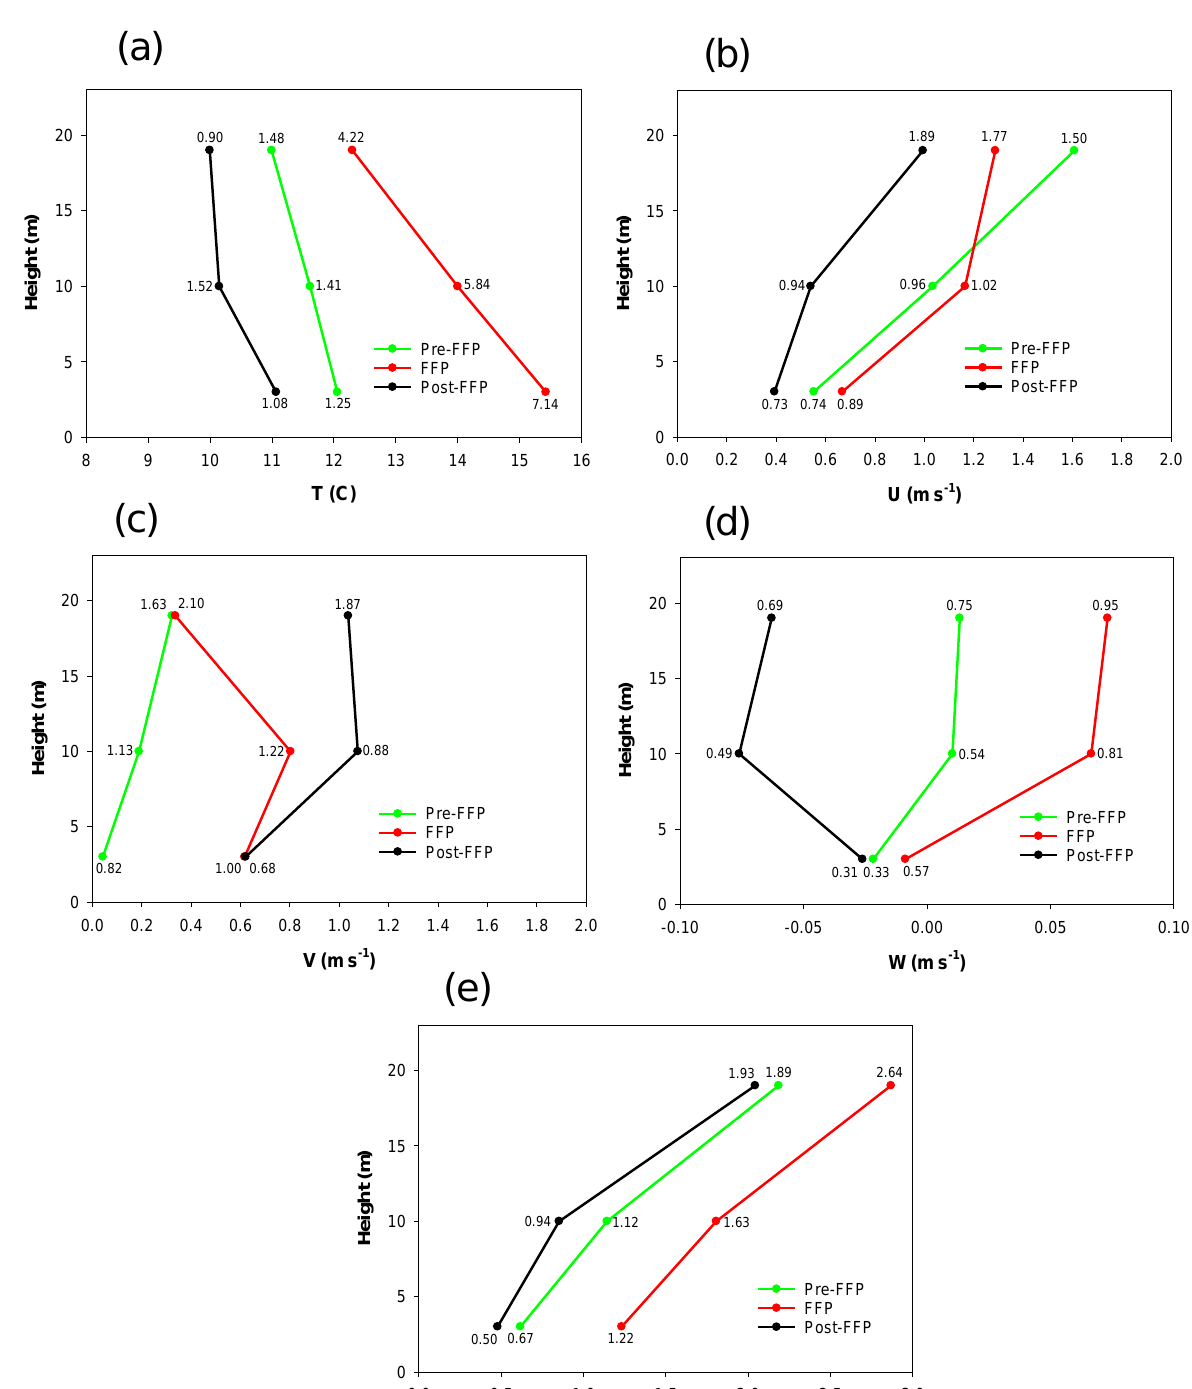
Figure 5. Mean ( a ) temperatures ( T ), ( b ) tilt-corrected zonal wind velocities ( U ), ( c ) tilt-corrected meridional wind velocities ( V ), ( d ) tilt-corrected vertical wind velocities ( W ), and ( e ) turbulent kinetic energy ( TKE ) at 3 m, 10 m, and 19 m AGL during the pre-FFP, FFP, and post-FFP periods, computed from all five in situ towers. Numbers adjacent to data points indicate standard deviations.